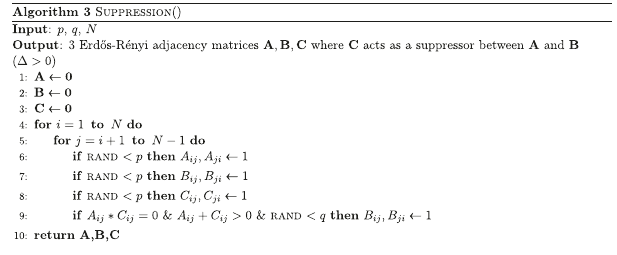
Algorithm 3 encapsulates the generative model. The following